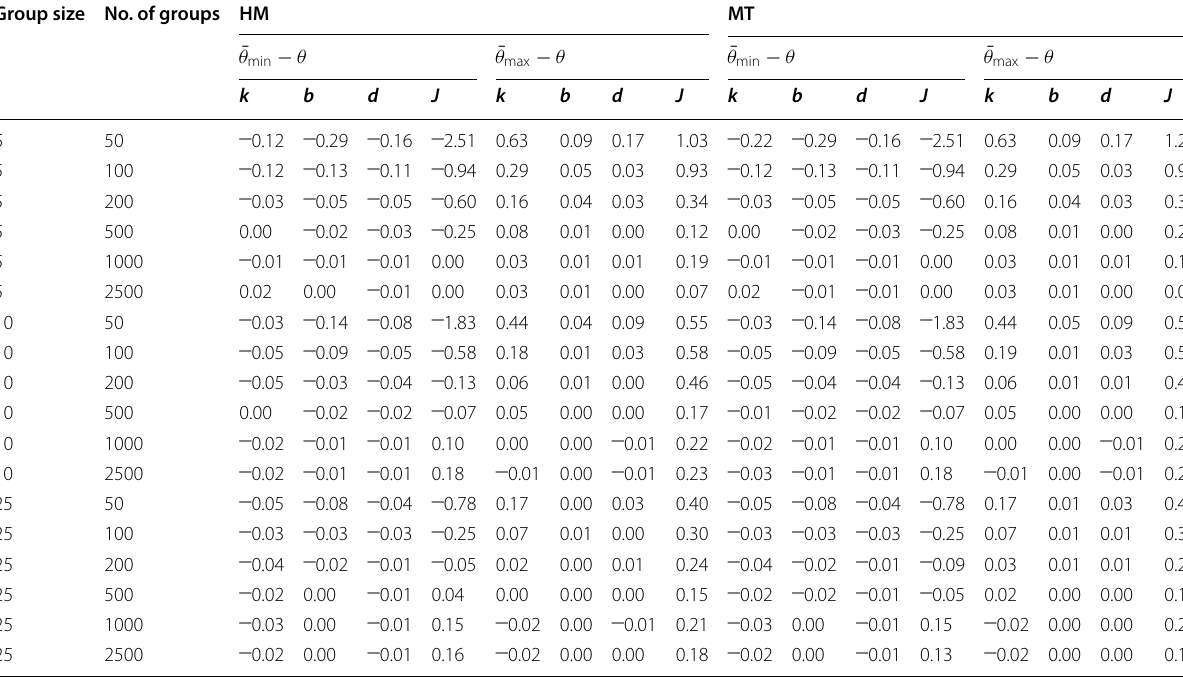
50 Monte Carlo simulations, 10 missing values in each simulation